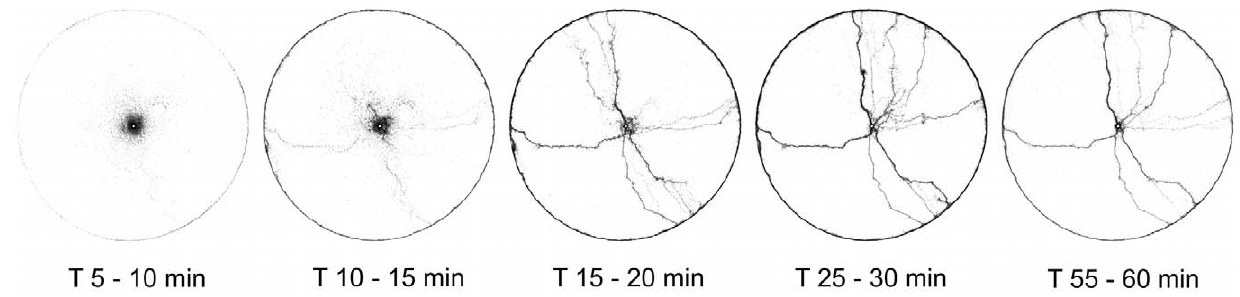
Figure 1. Evolution of the pattern formed by one colony (T09) over time. Each picture is obtained by summing all the ants detected from arena-level snapshots during 5 minutes (300 snapshots). The contrast and gamma are adjusted to make single ants visible in the images.